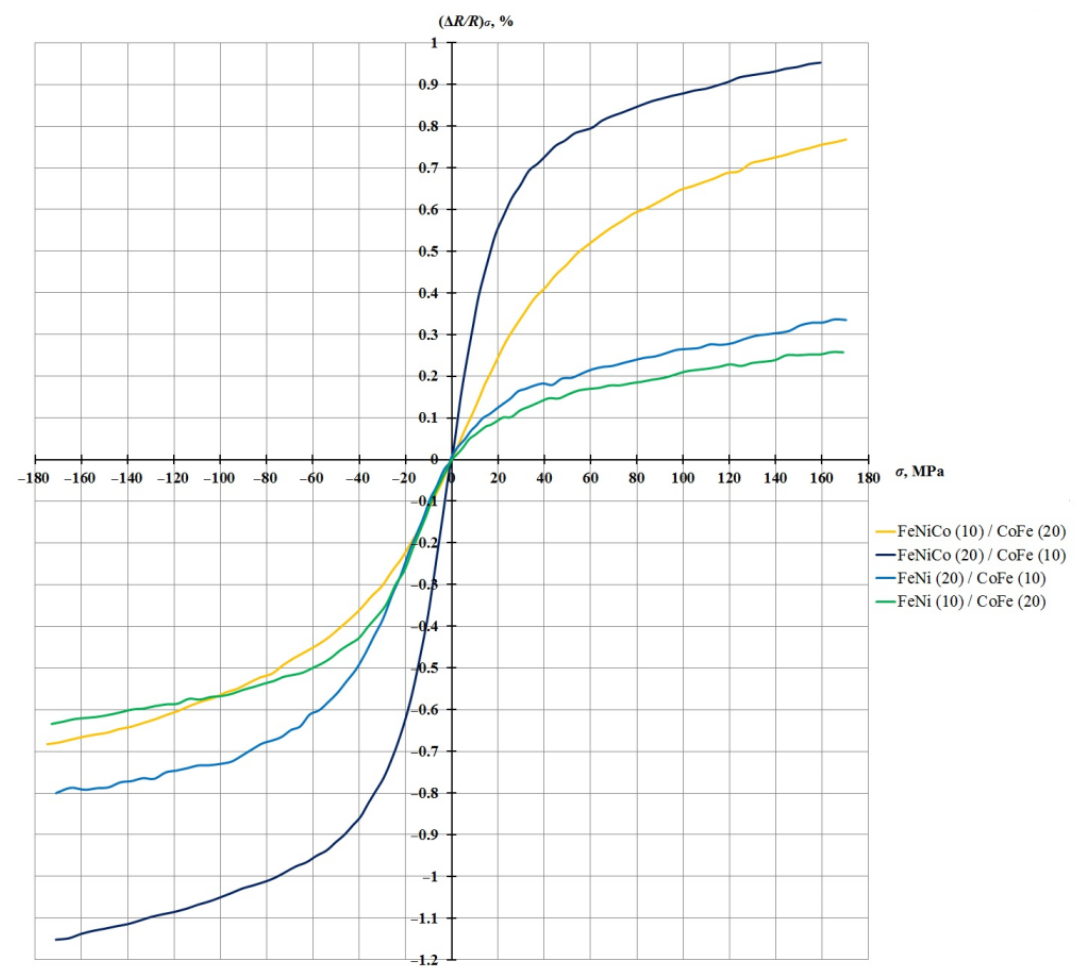
Figure 9. Graph of the dependence of the value of the relative change in the resistance due to the load on the value of the mechanical compressive/tensile stresses for the FeNiCo/CoFe and FeNi/CoFe nanostructures (layer thickness in nm). Table 3. Sensitivity of nanostructures to mechanical compressive/tensile stresses (layer thickness in